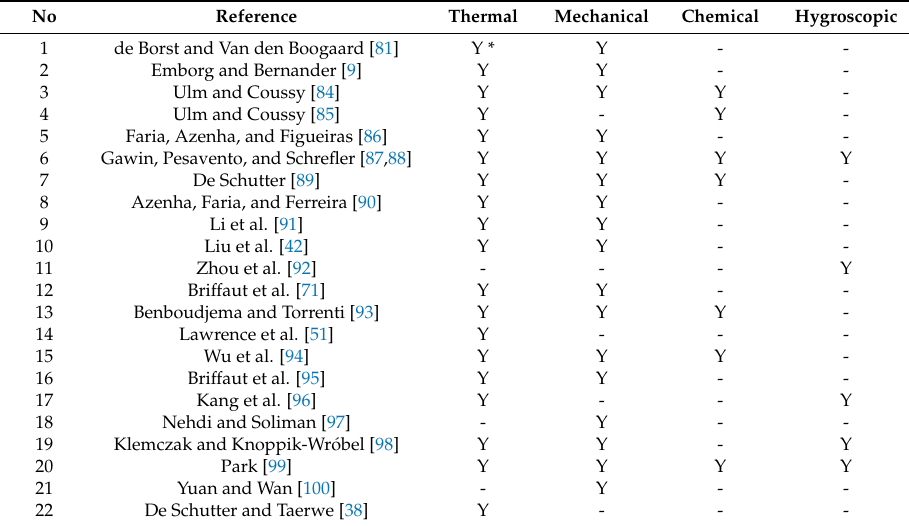
*Means “Yes” for thermal, mechanical, chemical, and hygroscopic